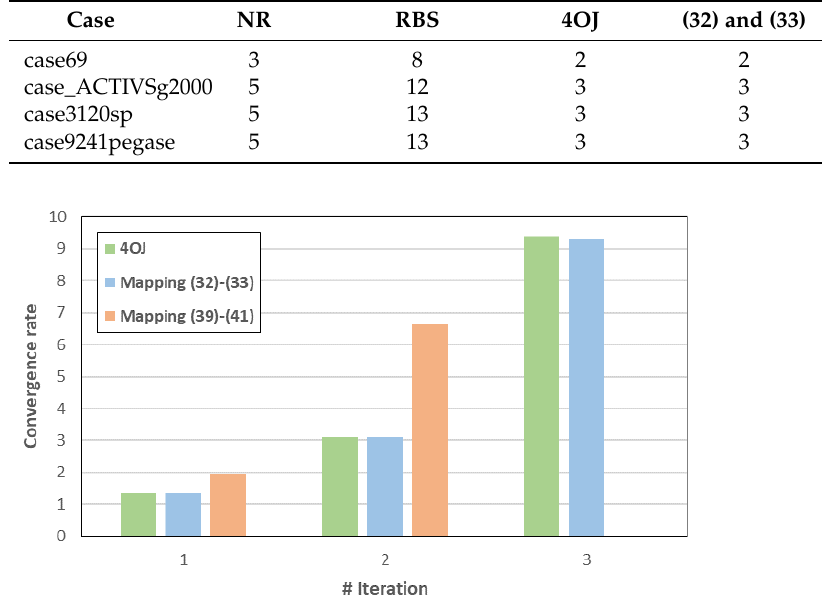
Figure 2. Convergence rates of 4OJ and the developed methods for the ‘case9241pegase’ .